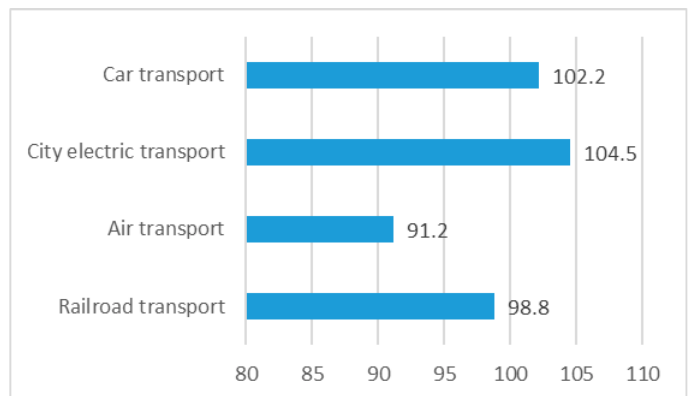
Figure 3. Index transport of tariffs for passenger transportation in March 2020 as a percentage of December 2019 [69].